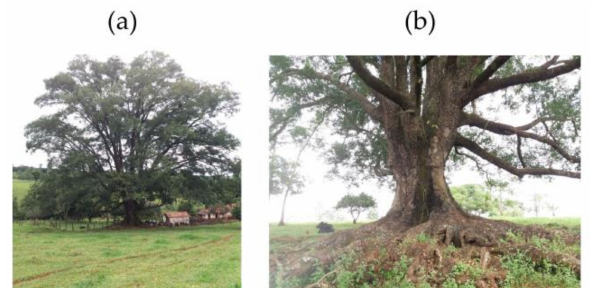
Figure 7. Characterization of the dimensions of the largest open-grown tree sampled—a Cariniana estrellensis (Raddi) Kuntze individual from the Lecythidaceae botanic family. Perspectives of the tree crown dimensions is shown in ( a ), and a tree diameter characteristic is shown in ( b